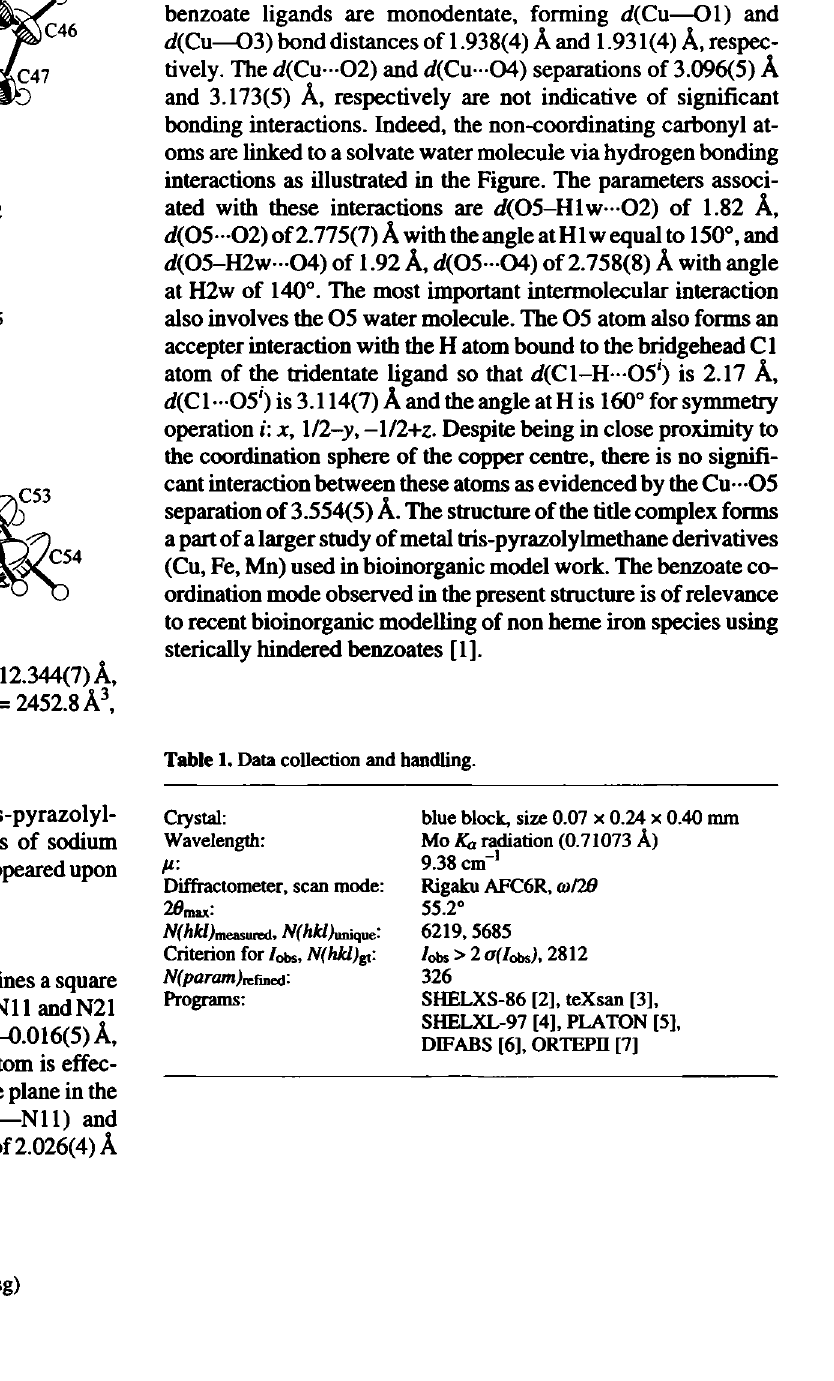
Table 1. Data collection and